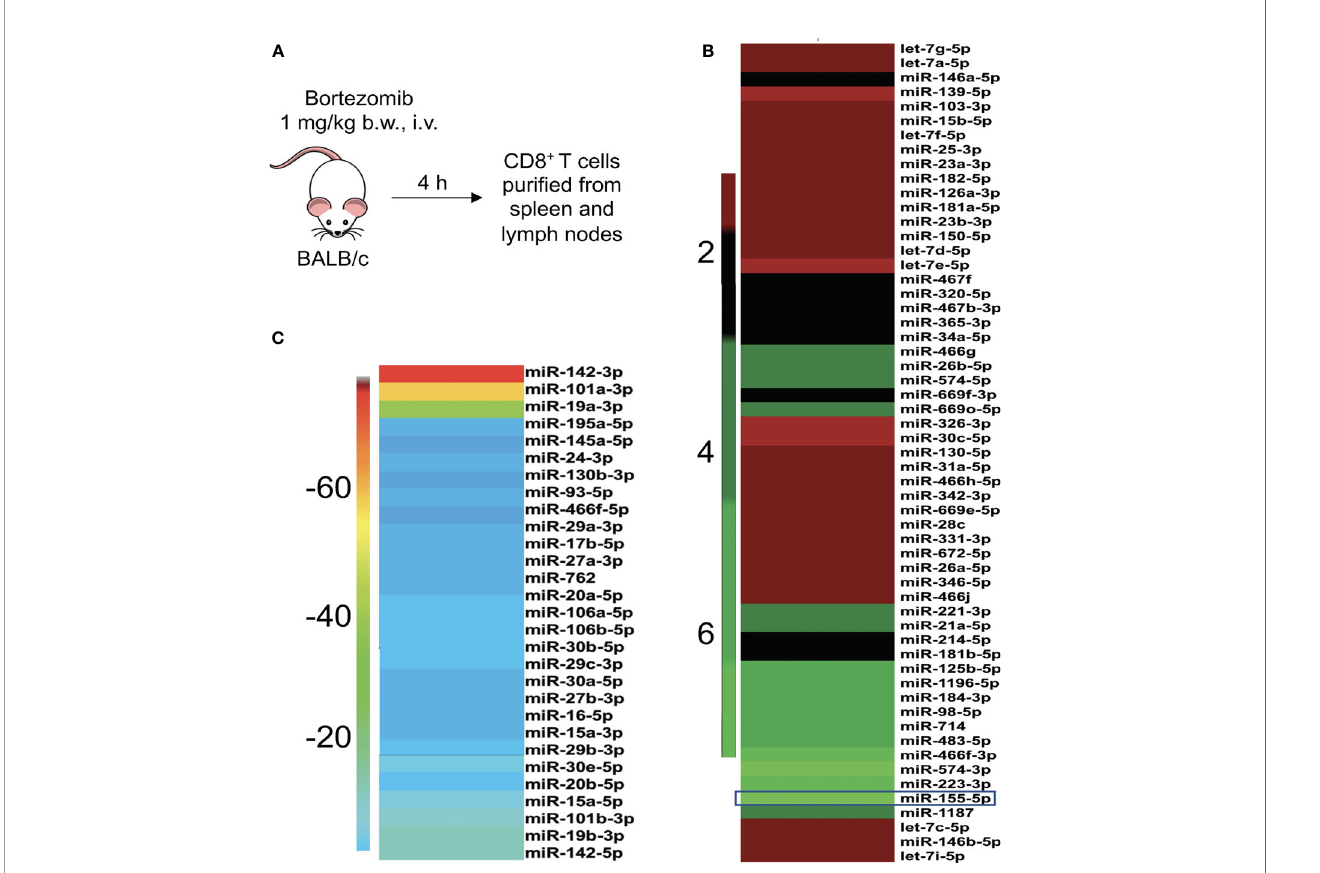
FIGURE 1 | Bortezomib administration in mice affects the expression of miRNAs in T cells. (A) BALB/c wild-type mice were treated with bortezomib intravenously (1 mg/kg body weight, approximately 15 nM dose by blood volume). Mice were euthanized 4 h post injection of bortezomib and CD8 + T cells were puri fi ed from a pool of spleen and lymph nodes. The miScript PCR microarray analysis was performed on miRNA isolated from CD8 + T cells. The fold changes of upregulated (B) and downregulated (C) miRNAs upon bortezomib treatment are depicted by heat plots with a color scale indicated on the